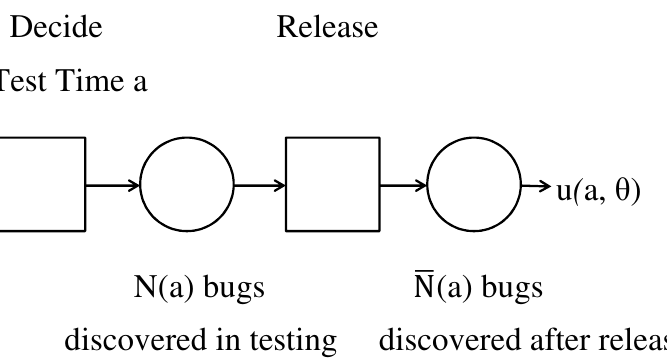
Figure 7. The decision tree for single-stage